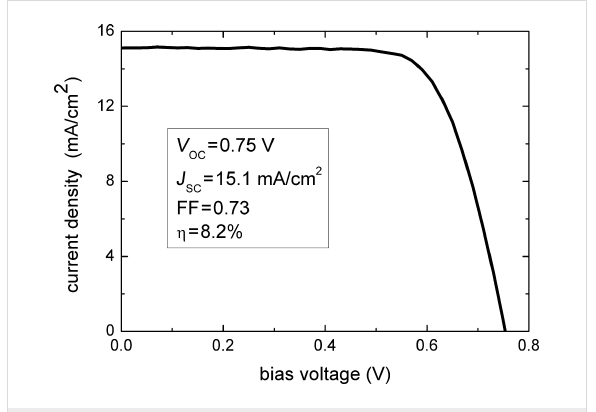
Figure 7: Example of a J – V characteristic of a DSSC based on the studied PA; the photovoltaic parameters are also